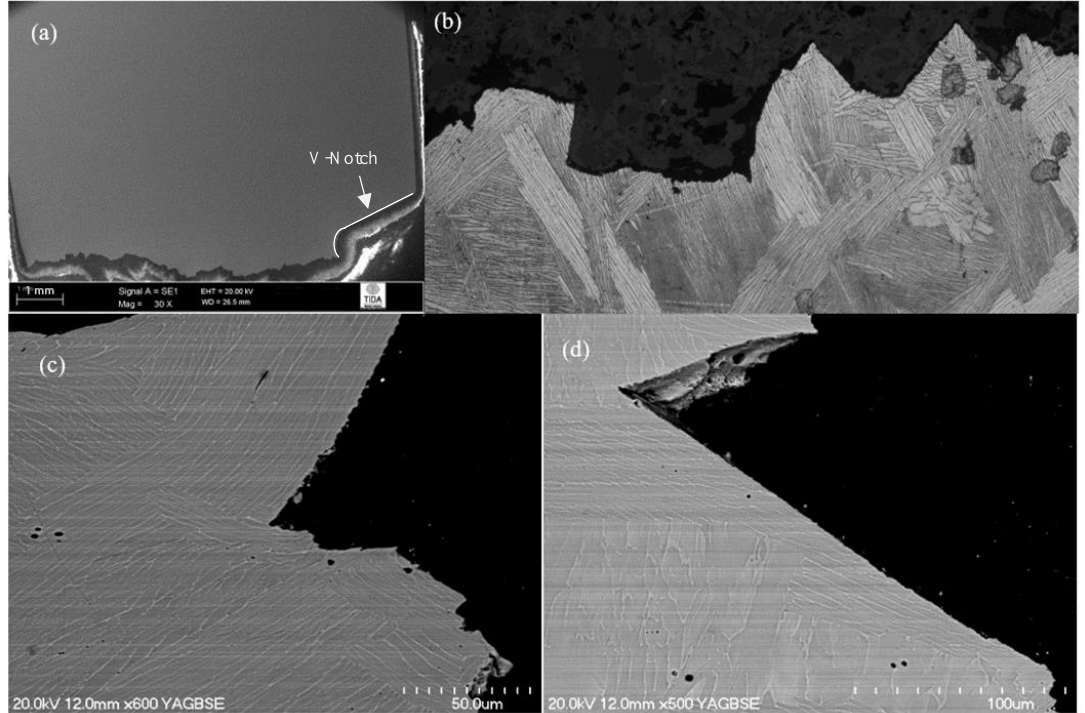
Figure 5. Crack propagation behaviour of 1065 °C/1 h, FC, 730 °C/2 h heat-treated material: ( a ) overall crack path; ( b ) transgranular fracture with relatively sharp crack deflection; ( c , d ) microstructural features causing a significant change to crack path.